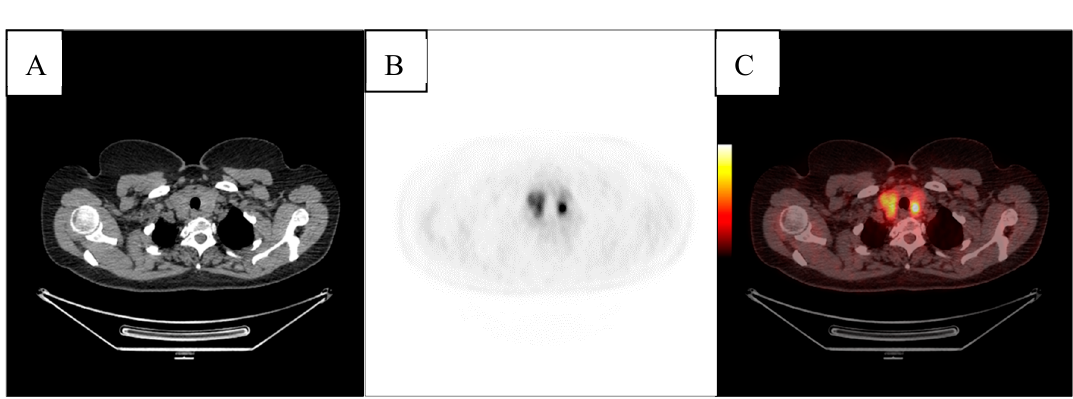
Figure 2. Axial section computed tomography (CT) ( A ), axial section positron emission tomography (PET) ( B ), and fusion ( C ) Fluorine-18 (F18)-18 fluoro-2-deoxy- D -glucose (FDG)-positron emission tomography/computed tomography (PET/CT) showing an increased FDG uptake in the multinodular thyroid gland of a patient followed-up with FDG PET/CT for cervix cancer; the histology report after thyroidectomy revealed papillary thyroid carcinoma incidentally identified in PET /